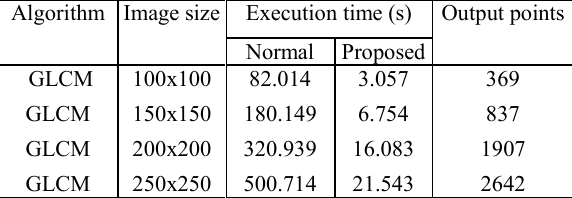
Table 2: Comparison of algorithm performance for calculation of GLCM parameters for images at